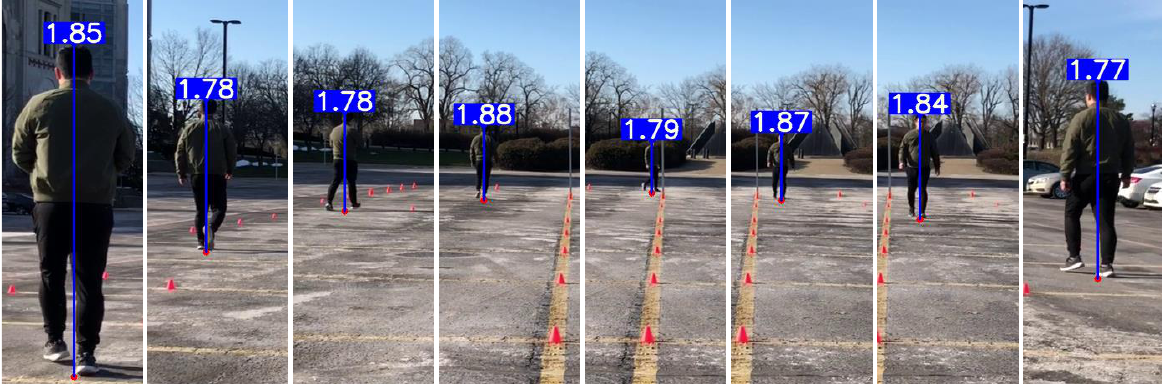
Figure 8. 2D image with bottles, sports ball, suitcase, person on the ground. MOHE-Net estimated object heights are displayed inside blue boxes. All values are reported in meters.